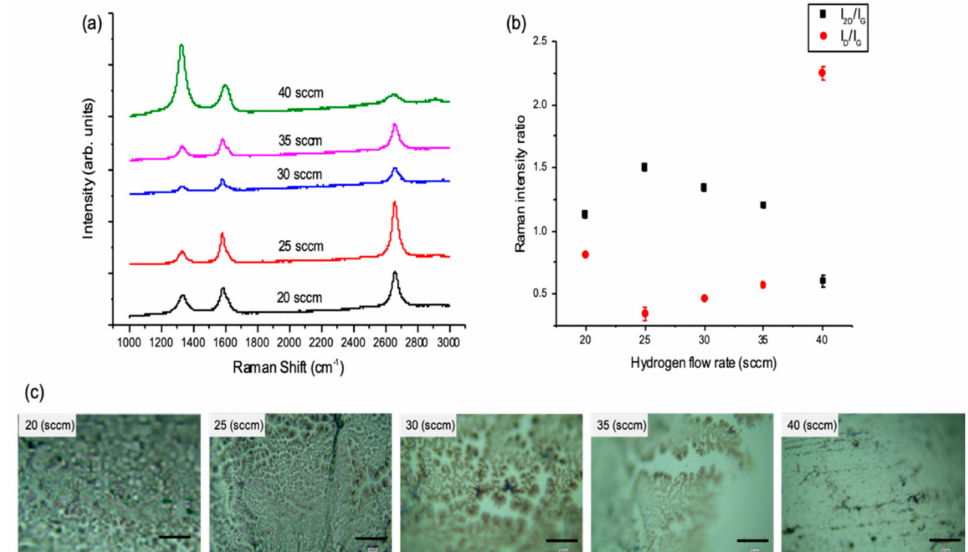
Figure 2. ( a ) Raman spectra of graphene grown on liquid Sn showing the e ff ect of changing the H 2 flow rate. ( b ) Average Raman intensity ratio I 2D / I G and I D / I G values vs. the H 2 flow rate based on maps data. (Error bars are smaller than some data points.) ( c ) Optical images of the grown graphene films (scale bar: 20 µ m), some blurriness is due to the surface curvature of the solidified Sn after melting (APCVD, T = 1120 ◦ C, (20–40) H 2 / 250 Ar / 5 CH 4 sccm, t = 5